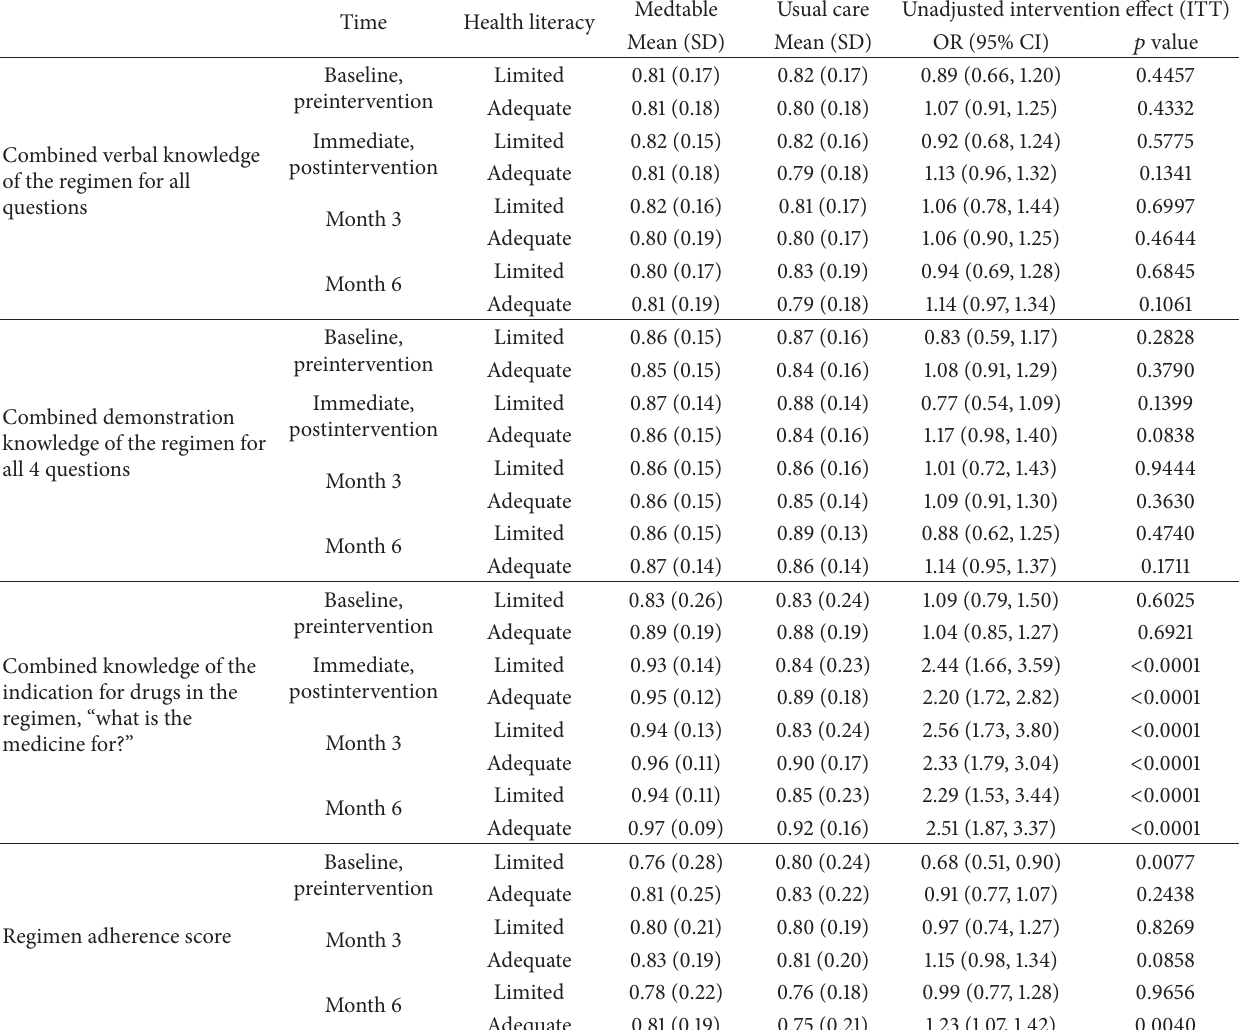
Table 8: Stratified analysis by patients’ literacy status for knowledge of and adherence to the noninjectable medication regimen before and after intervention: Medtable versus usual